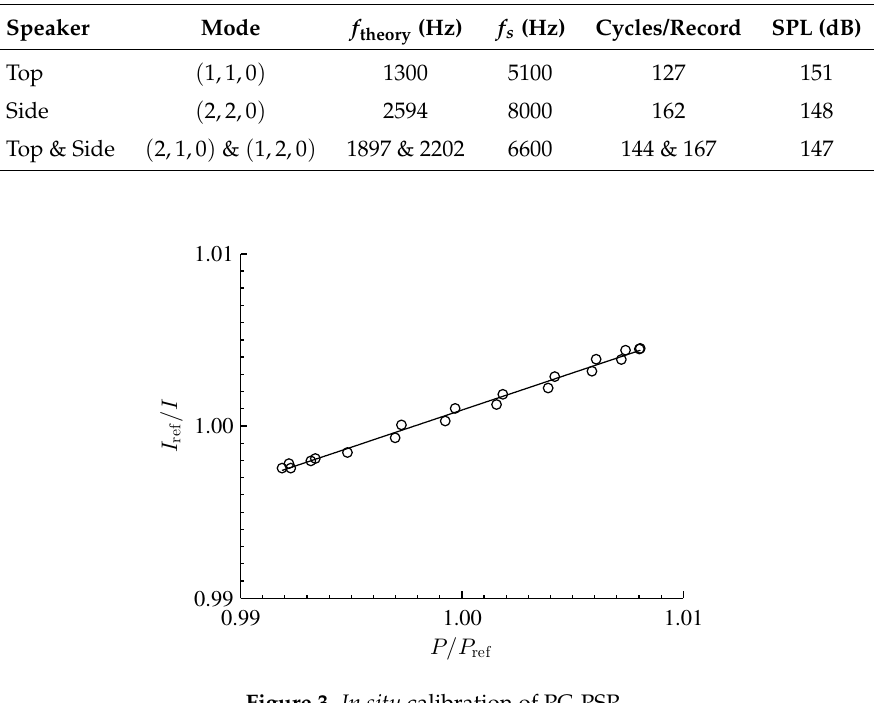
Figure 3. In situ calibration of